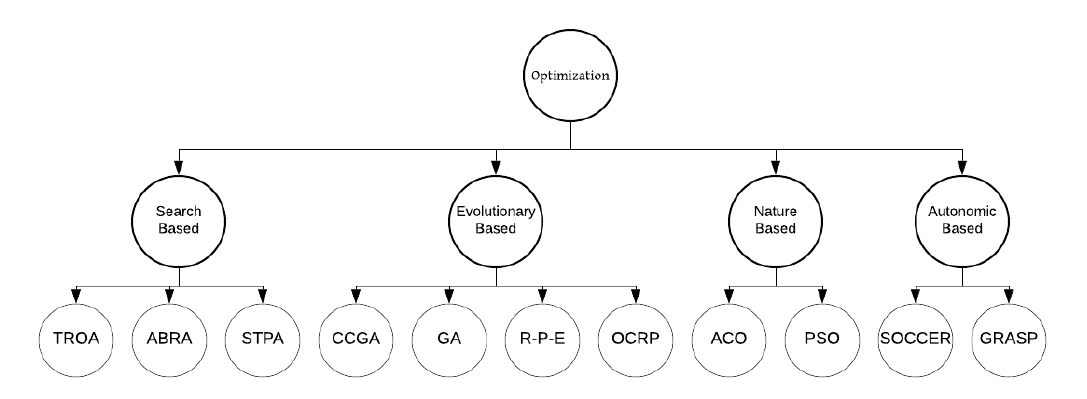
Figure 1. Optimization techniques in